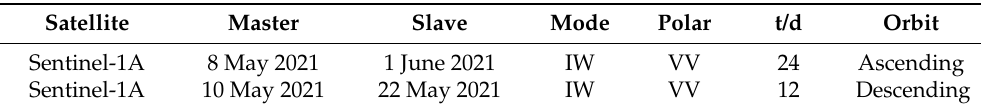
Table 1. Sentinel-1A data parameters.